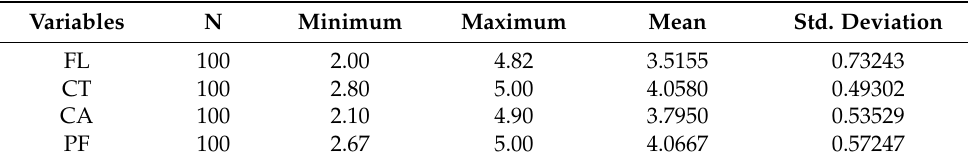
Figure 2. The number of employees. Table 2. Descriptive Statistics.